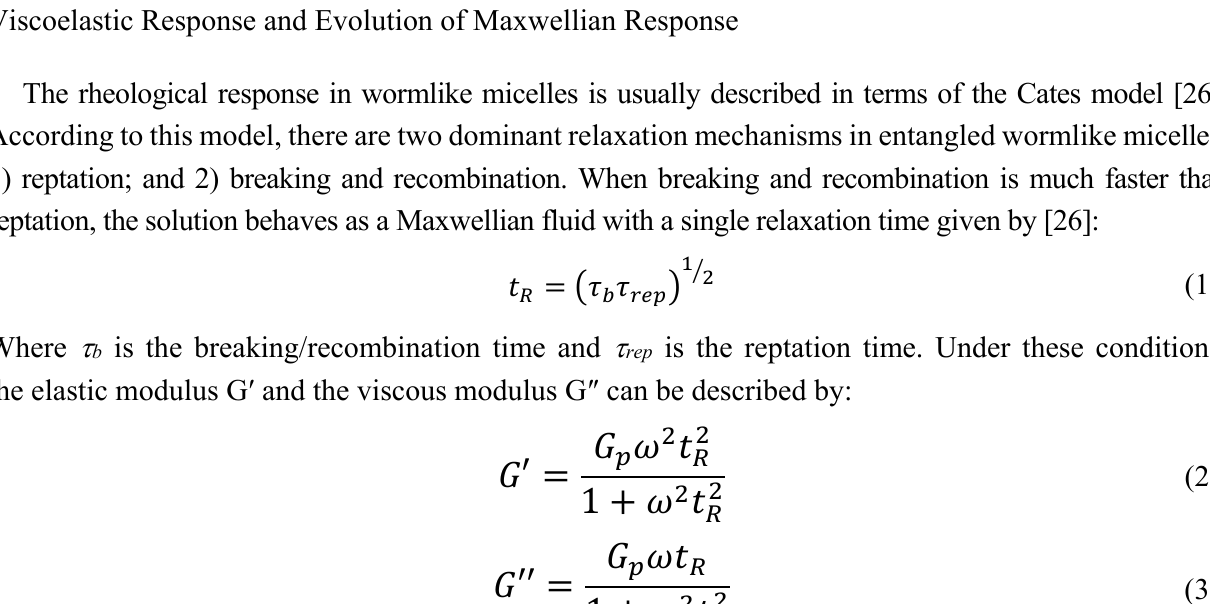
Figure 3. Viscosity exhibiting a maximum at 250 mM NaCl